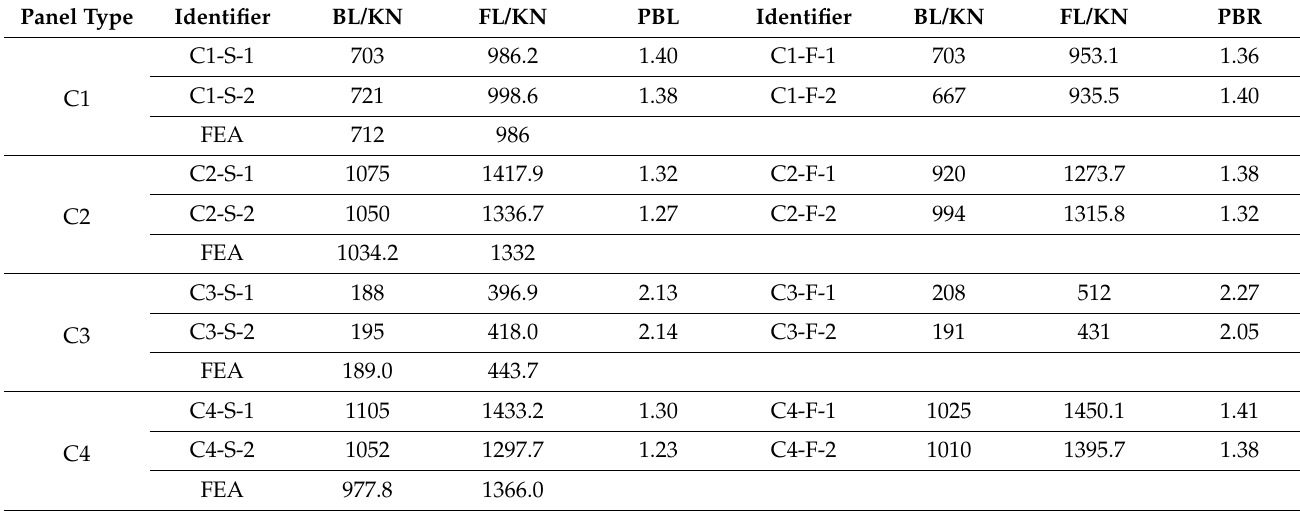
Table 7. Buckling load and failure load for all the